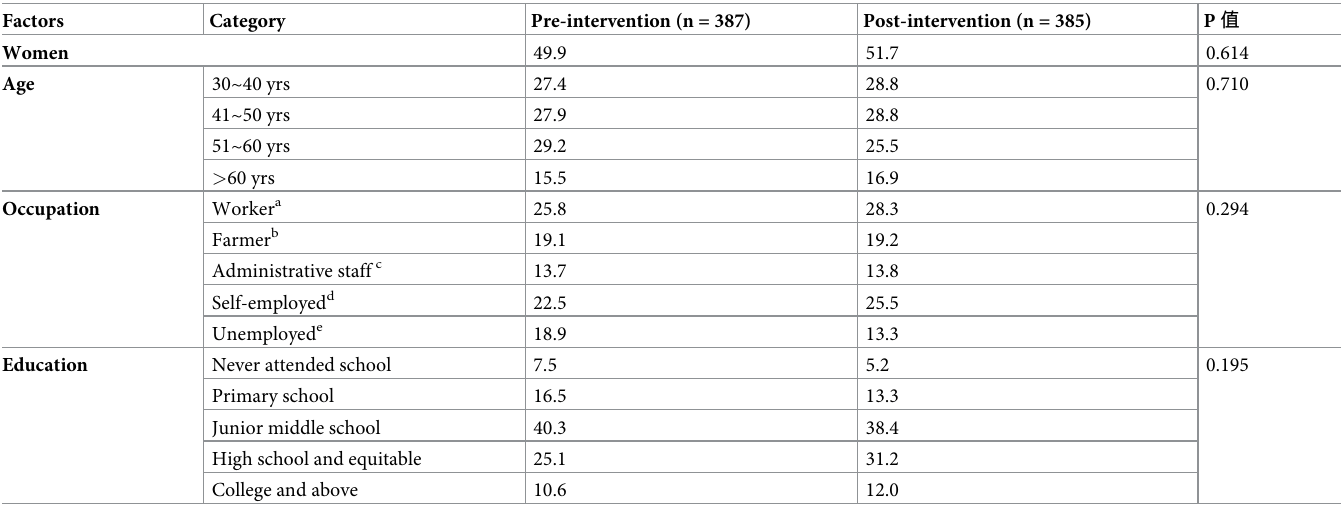
Table 3. Demographic characteristics of study participants in the resident convenience sample surveys before and after the